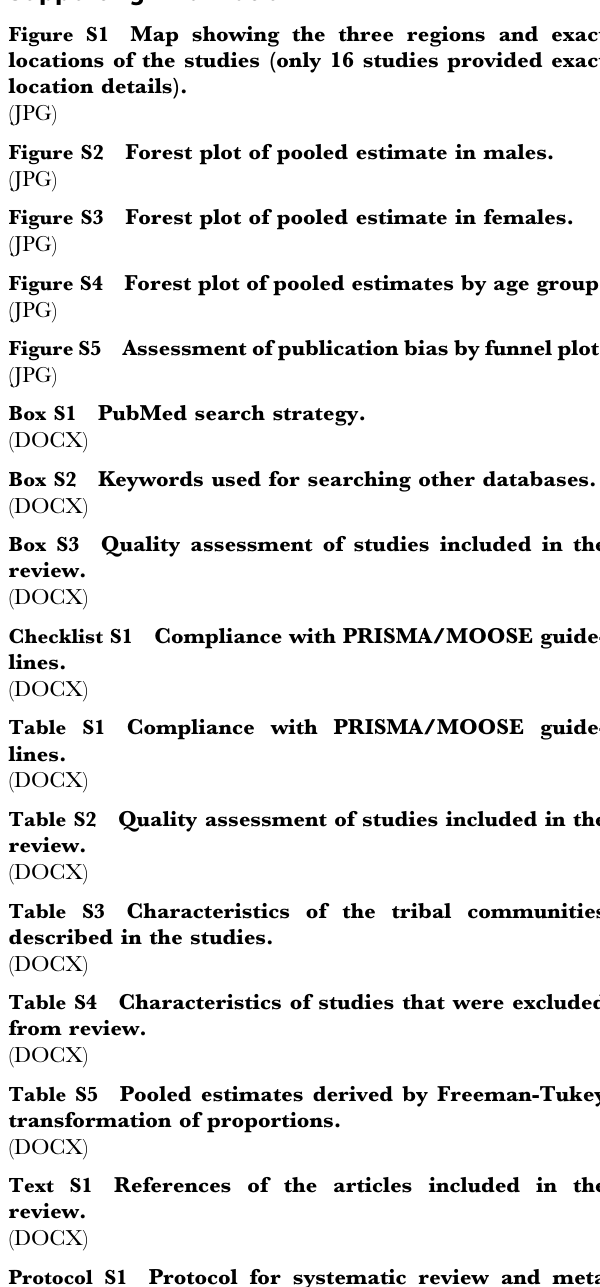
Figure S2 Forest plot of pooled estimate in males. Figure S3 Forest plot of pooled estimate in females. Figure S4 Forest plot of pooled estimates by age group. Figure S5 Assessment of publication bias by funnel plot.